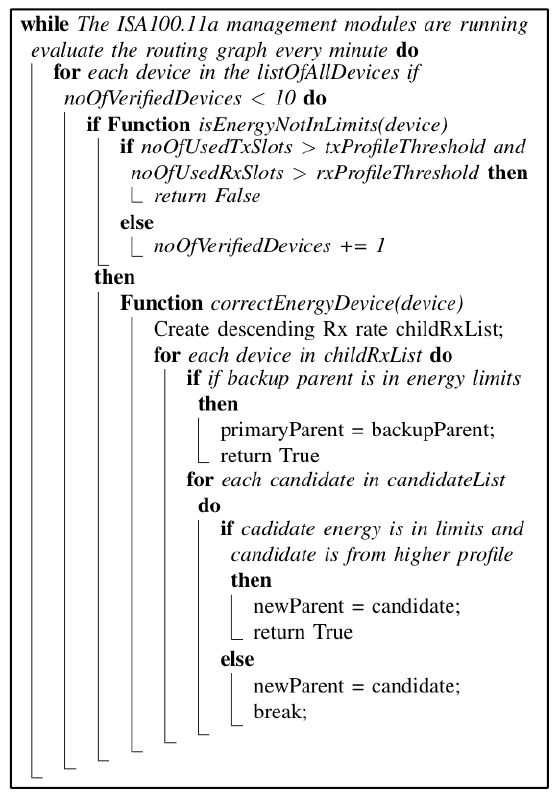
Figure 3. The PEAR post-network-formation pseudocode algorithm.